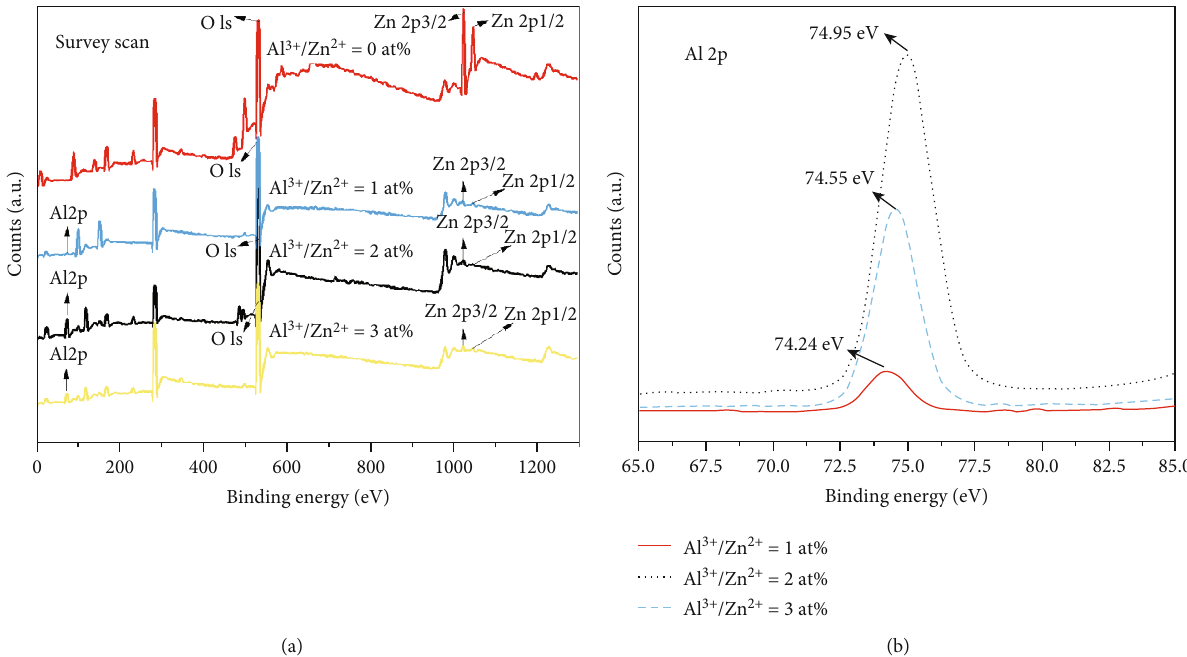
Figure 6: XPS spectra of (a) survey scan and (b) Al 2p peaks of the ZnO samples with di ff erent Al 3+ /Zn 2+ ratio in the